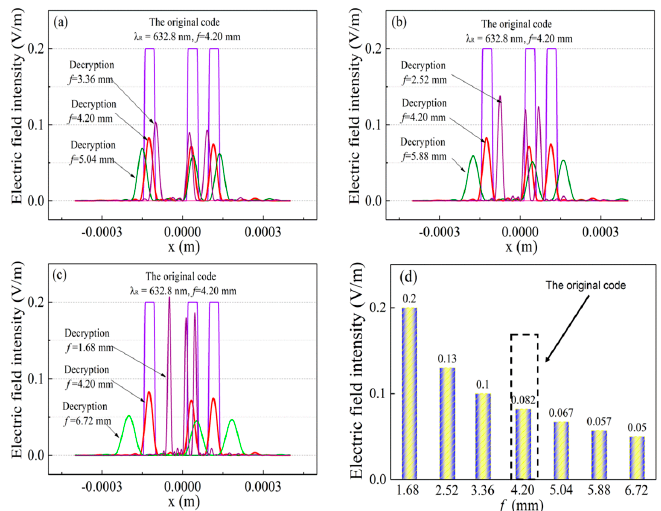
Figure 8. Comparisons between the original code of 4.20 mm and the decrypted code of different focal lengths f : ( a ) 3.36 mm, 4.20 mm and 5.04 mm, ( b ) 2.52 mm, 4.20 mm and 5.88 mm, and ( c ) 1.68 mm, 4.20 mm and 6.72 mm; ( d ) electric field strength of data decrypted with different focal lengths from 1.68 mm to 6.72 mm .